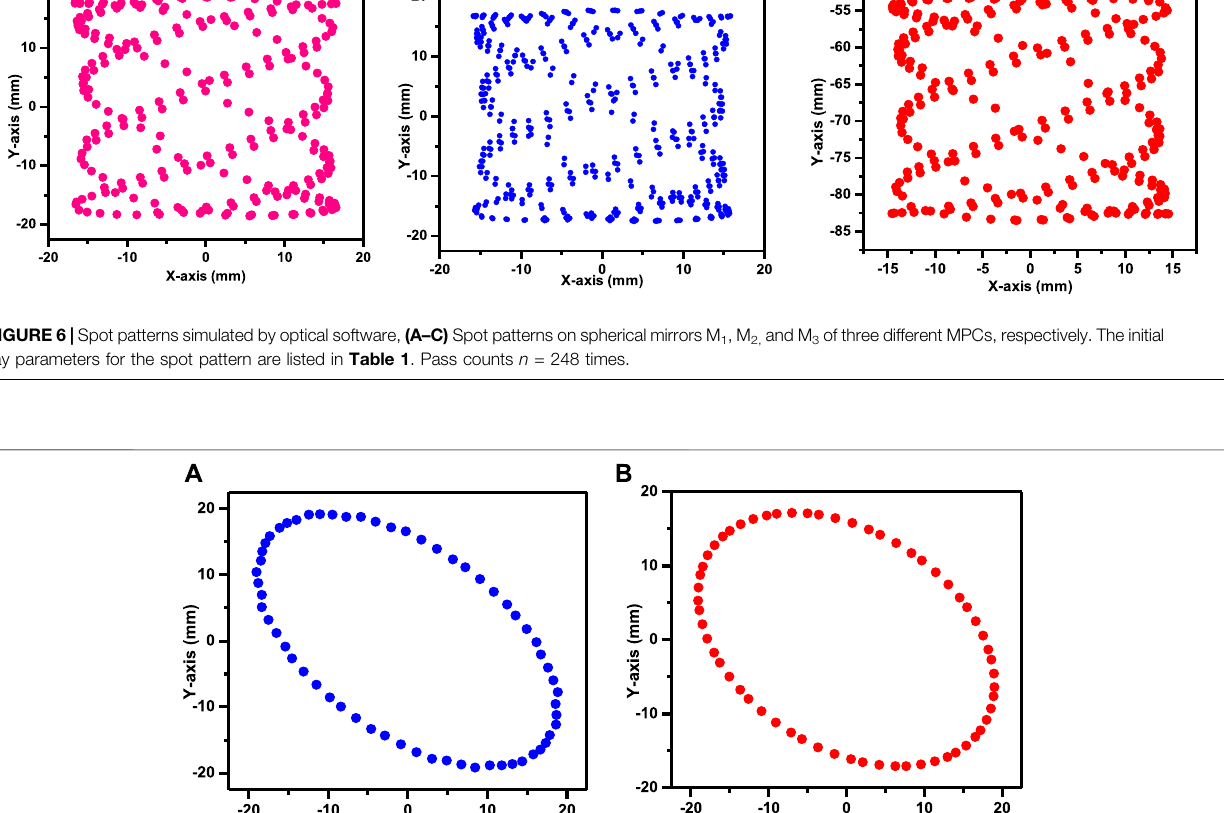
ray in the MPC. According to the ratio of OPL to V (RLV) in Table 1 , the most ef fi cient space utilization is the spot pattern with a value of 22 in Figure 6 . Those extraordinary spot patterns